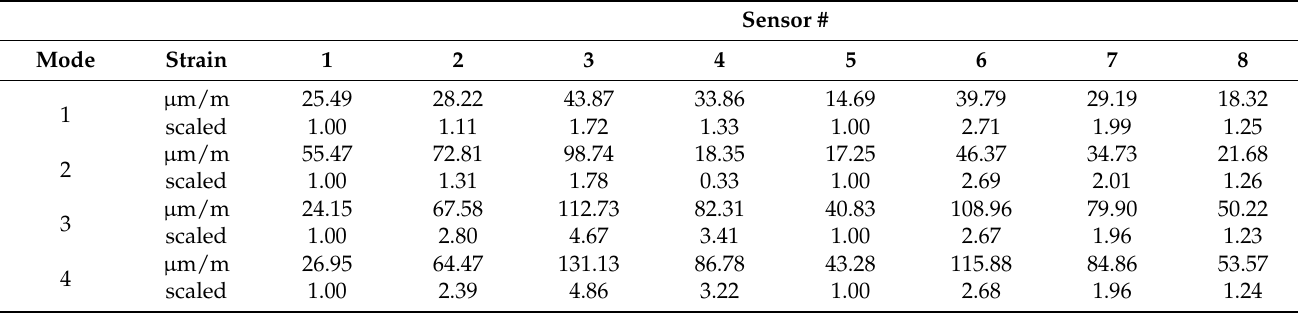
Table A2. Strain sensor data for the undamaged plate excited with 2 V